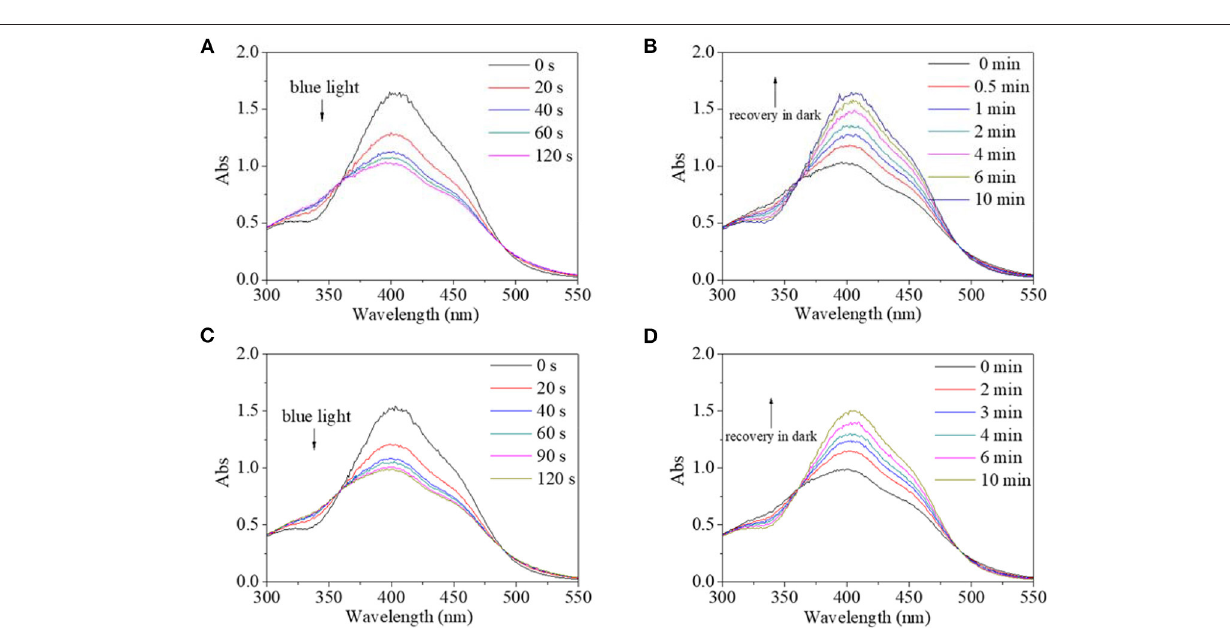
was also verified to be another effective excitation source for PBLG2. When it came to solvent effects, the addition of alcohol and water as cosolvents had little effect on the trans → cis